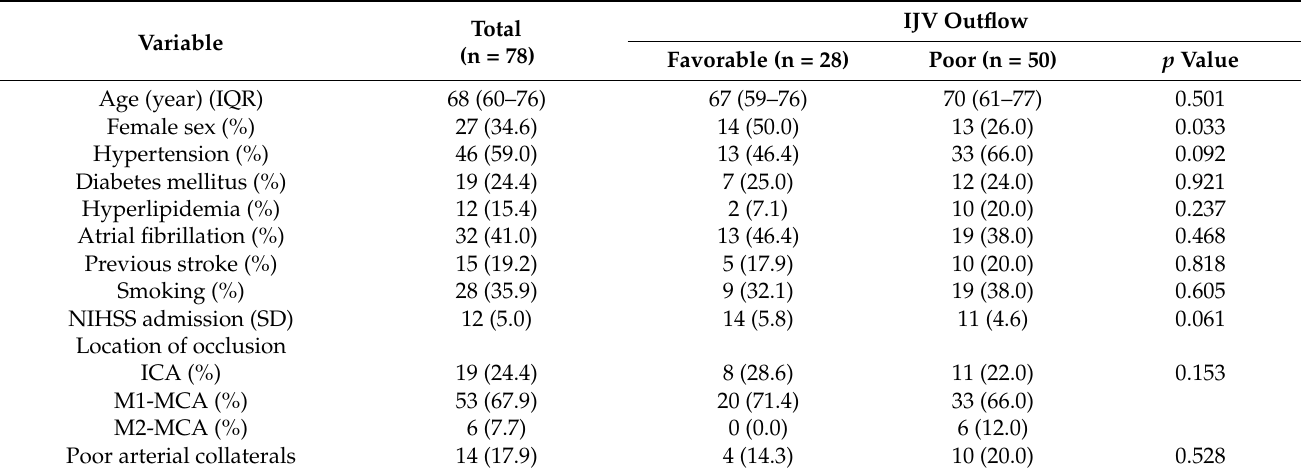
Table 1. Clinical and imaging characteristics of the study cohort classified by the outflow of trans- verse sinus and internal jugular vein on the affected side.